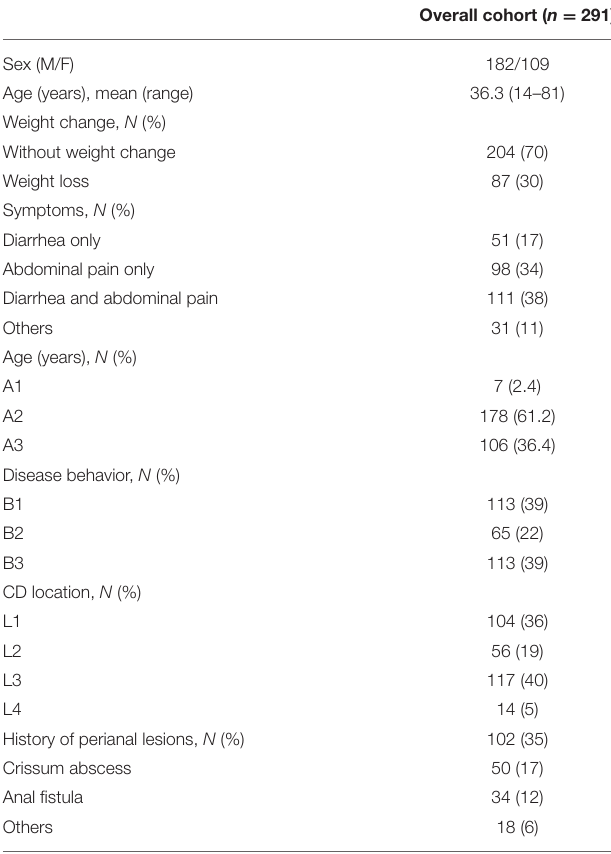
TABLE 1 | Baseline characteristics of patients with CD at the time of